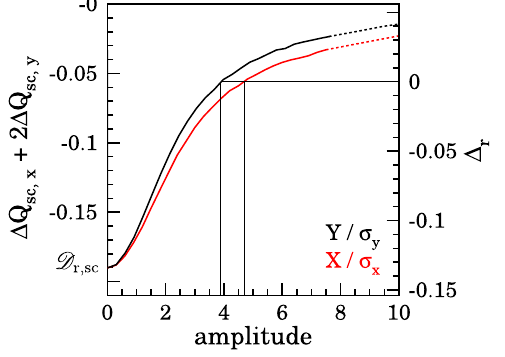
2 Δ Q and Δ r as a sc ; x þ sc ; y